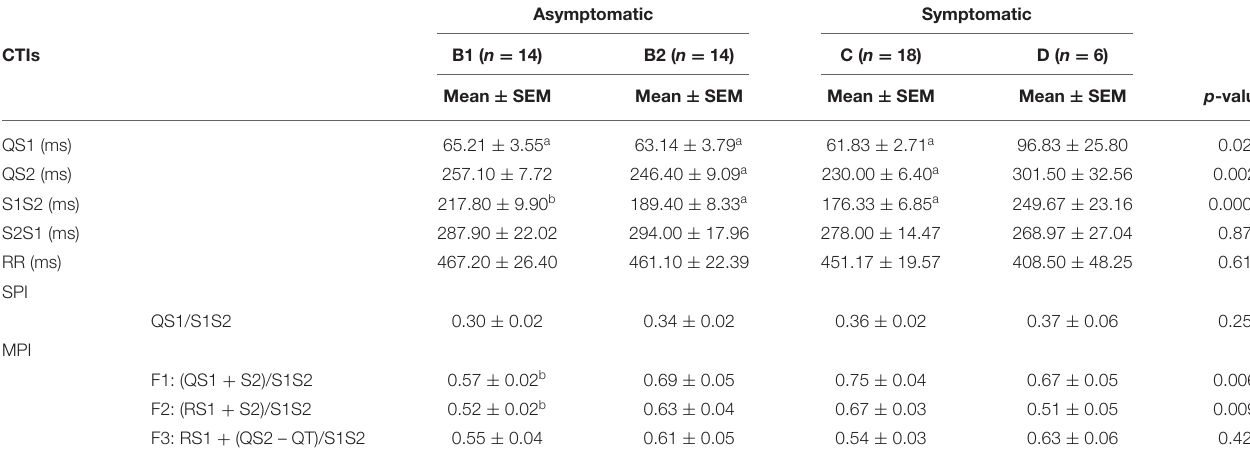
TABLE 3 | CTI parameters were measured using Eko® DUO ECG + Stethoscope device in various stages of MMVD. Asymptomatic